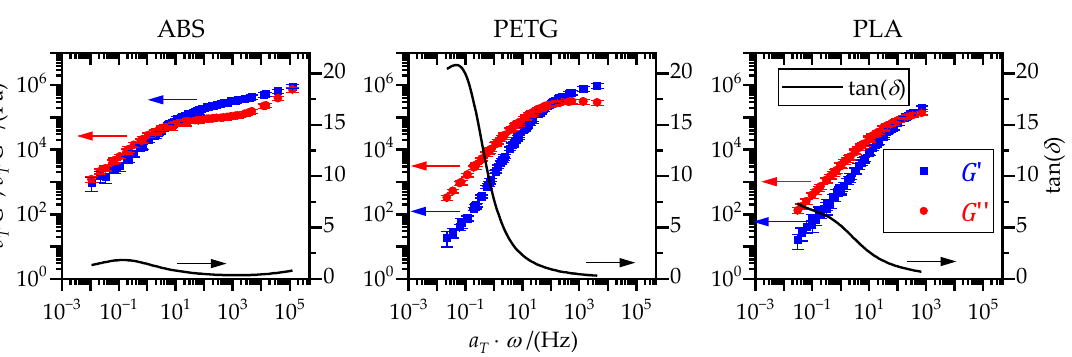
Figure 7. Frequency dependence of storage modulus, G ’, loss modulus, G ” , and loss factor, tan( δ ), at a reference temperature T 0 of 180 °C for the first run. The loss factor was determined based on smoothed master curves of the storage and loss modulus. For ABS as well as for PLA in the second and third run, no zero shear viscosity, η 0 , could be determined, as there was a continuous increase in viscosity for small frequencies, ω (cf. Figure 6). The plateau modulus, 𝐺 N0 , could not be obtained for PLA because there was not a minimum in G ’ nor a maximum in G ” in the available frequency range (cf. Fig- ure 7). Therefore, the reptation time, t d , which is calculated based on zero shear viscosity, η 0 , and plateau modulus, 𝐺 N0 , was not ascertainable for all polymers. Hence, only the rouse relaxation time, t ro , which could be determined for all polymers, was considered. To ac- count for the differences in viscous character of the polymer melts, the maximum of the loss factor, tan( δ )| max , in the available frequency range, ω , was considered. The maximum of the loss factor, tan( δ )| max and the rouse relaxation time, t ro , are listed in Table 3.